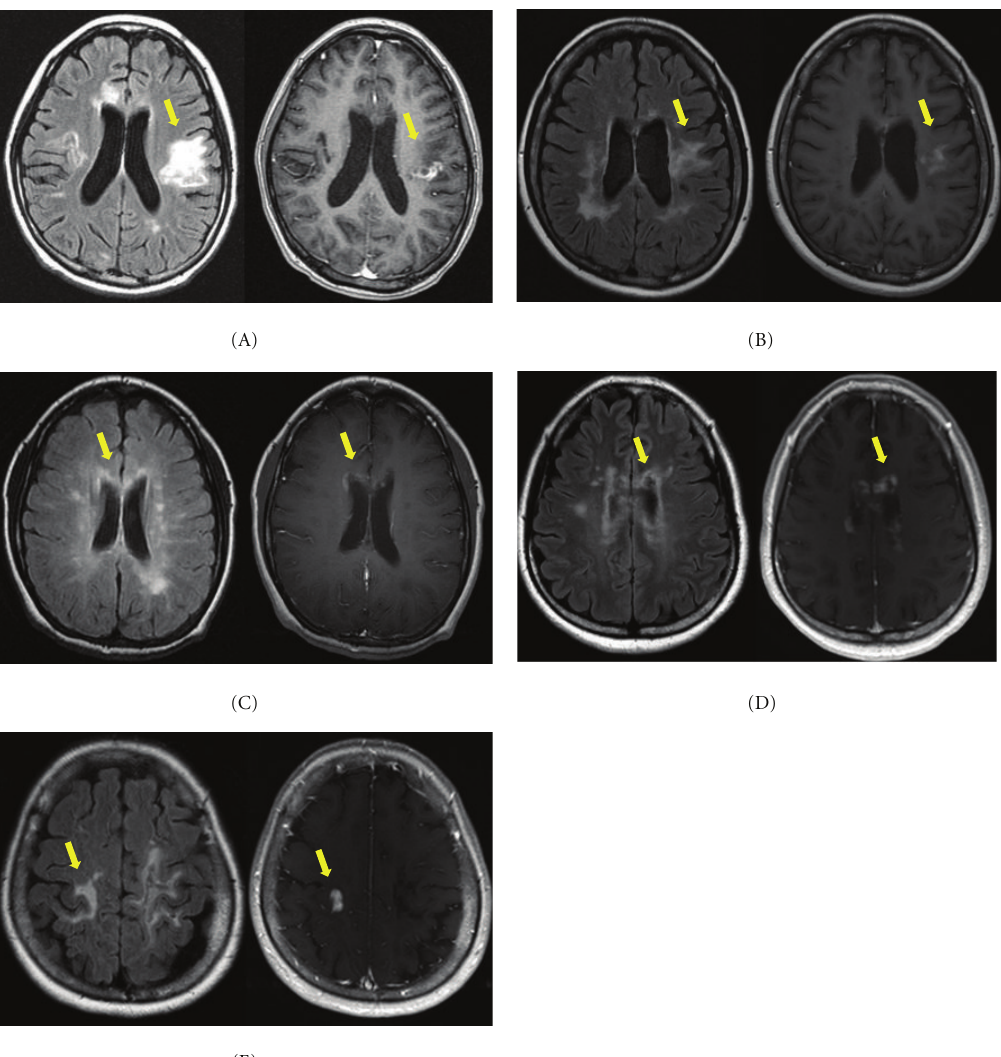
Figure 3: Paired fluid-attenuated inversion recovery (FLAIR) (left) and corresponding gadolinium-enhanced (right) axial images of patients who showed enhancement. Enhancement observed in extensive hemispheric lesions (A, B, and E) and periependymal lesions surrounding the lateral ventricles (C, D). The lesions reveal multiple patchy enhancement patterns with blurred margins, showing typical “cloud-like enhancement”. One exceptional lesion reveals well-marginated nodular enhancement at an extensive hemispheric lesion (E)